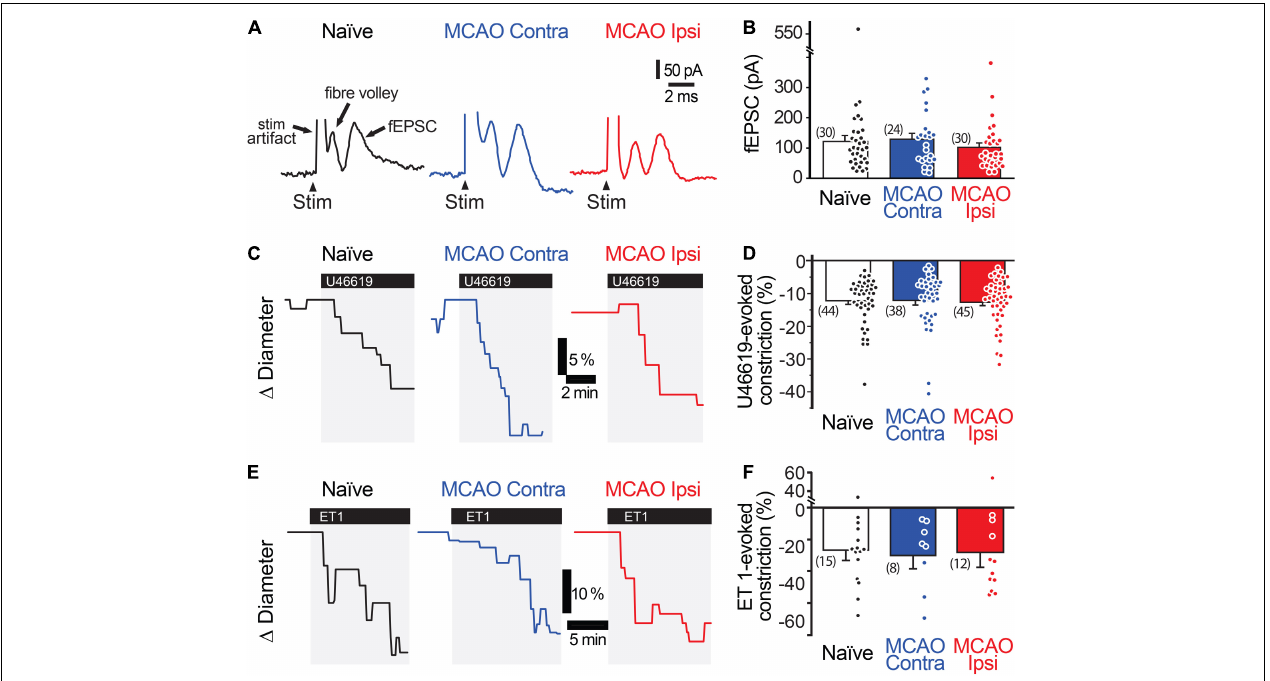
FIGURE 2 | Neuronal activity and vasocontractility are not reduced in the MCAO peri-infarct cortex. (A,B) Stimulation-evoked fEPSC are comparable in the MCAO Ipsi peri-infarct and the analogous region of the MCAO Contra and naïve slices. (C,D) 200 nM U46619 evokes a similar capillary constriction in all three regions. (E,F) ET-1 (10 nM), a more potent vasoconstrictor, evokes a stronger but statistically similar capillary constriction in all three regions. None of the comparisons were statistically significant based on ANOVA followed by Tukey’s HSD test. Number in parentheses above each bar indicates N .